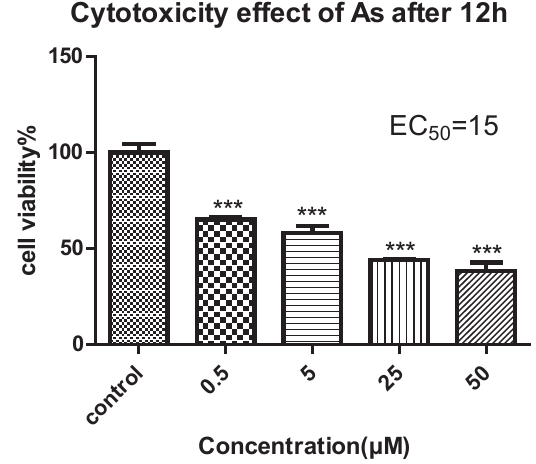
Figure 1: Viability of human lymphocytes following treatment with As for 12 h. Dose-dependent decease in lymphocyte viability observed at concentration higher than 0.5 µM. *** P < 0.001: significant difference compared to the control